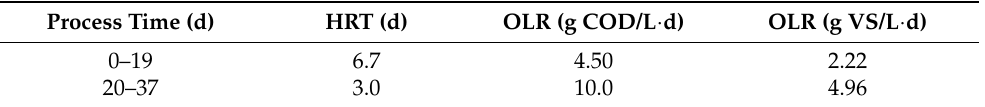
Table 1. Anaerobic digestion of BWW + PE (60:40, v / v ) in continuous conditions, in the hybrid anaerobic